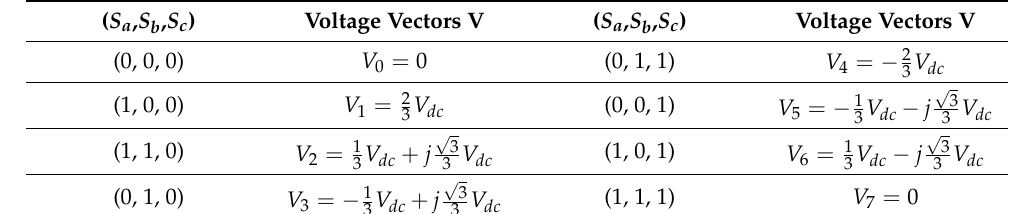
Table 2. Switching states and voltage vectors of the VSI.